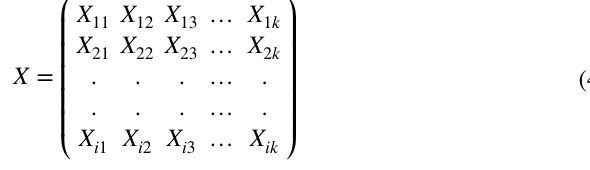
for performance